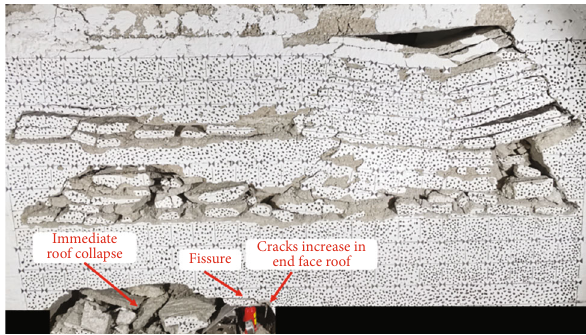
Figure 11: Further deterioration of roof conditions.